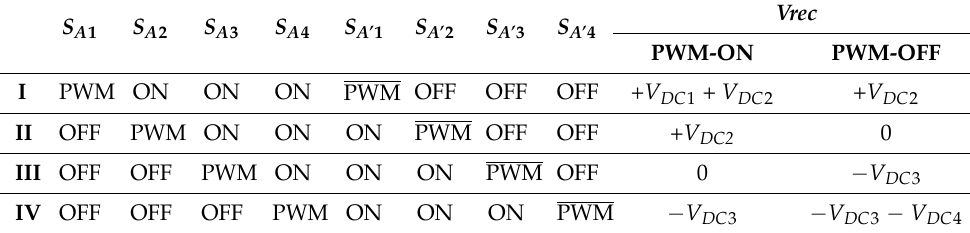
Table 1. Switching states and five-level DCMC input rectifier